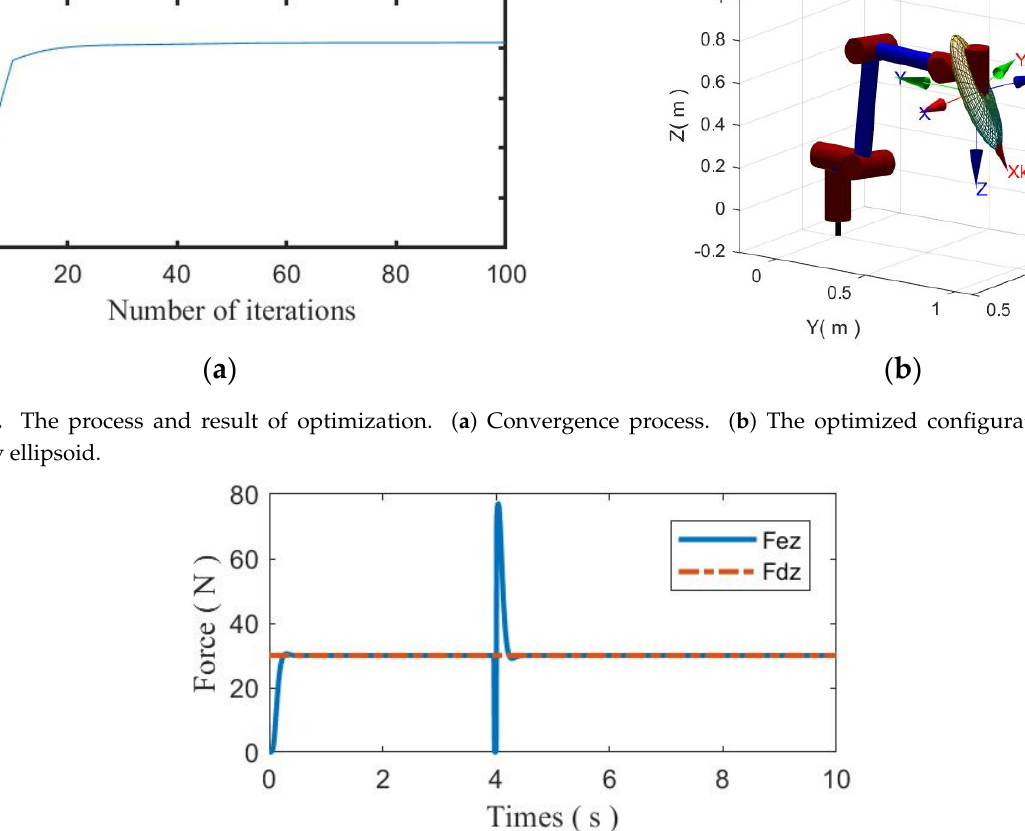
Figure 9. The contact force between shaft and hole in experiment 2.